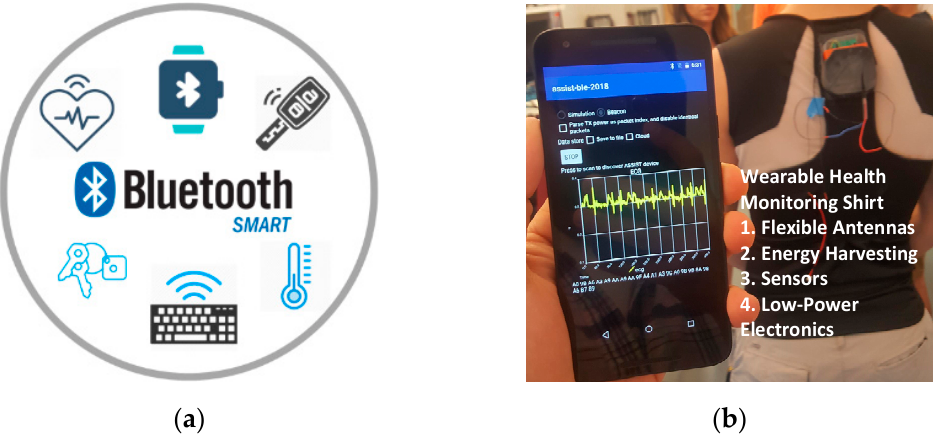
Figure 1. ( a ) Wide range of consumer IoT applications, ( b ) self-powered wireless sensor systems used in health monitoring purposes.